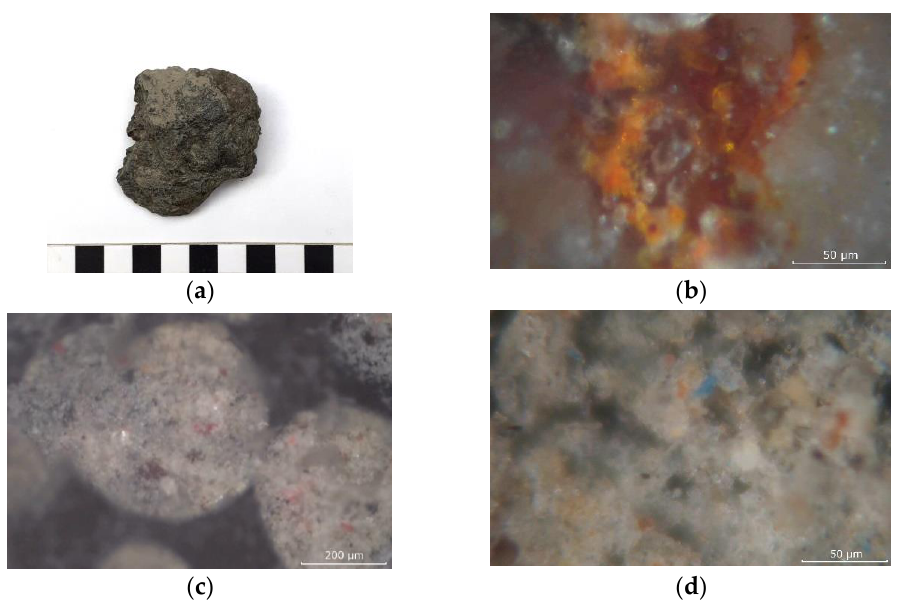
Figure 8. Temesa 3: ( a ) rock sample; ( b ) goethite lump (reflected light micrograph, crossed polarizers); ( c ) cuprite microcrystals inside nodules of metal oxides and sulfides (reflected light micrograph, crossed polarizers); ( d ) cuprite and chalcanthite microcrystals inside nodules of metal oxides and sulfides (reflected light micrograph, crossed polarizers).